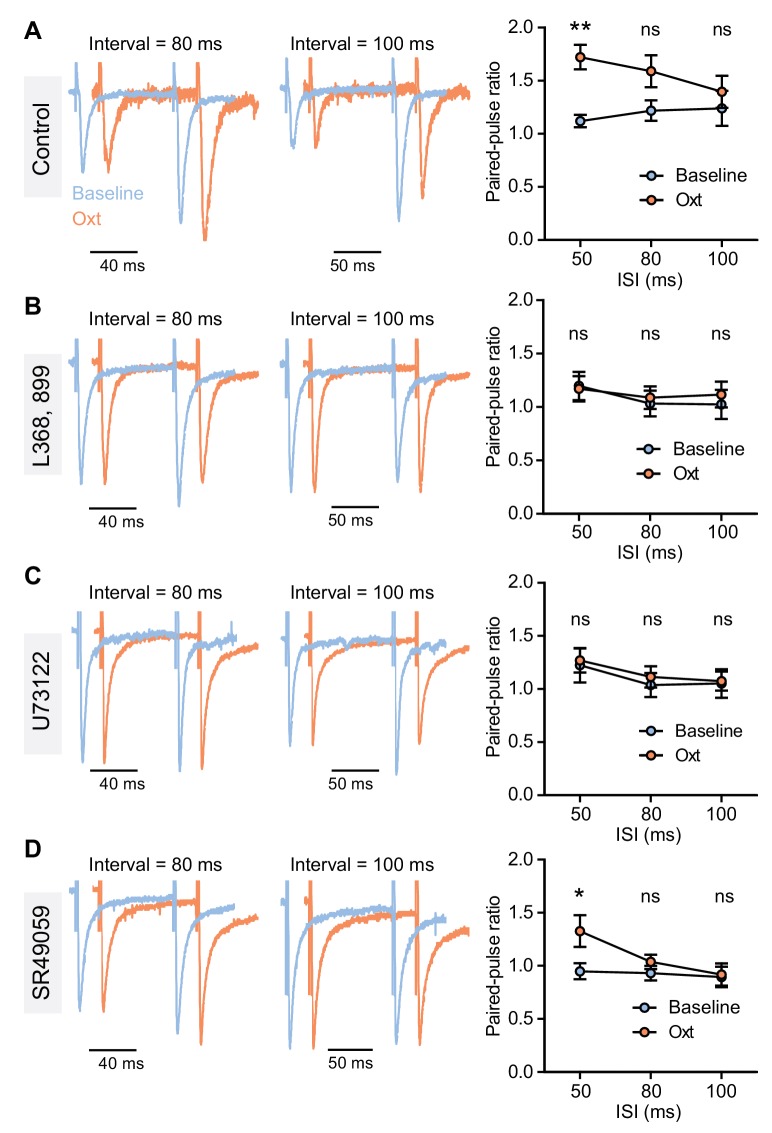
Oxytocinergic modulation of paired-pulse ratio in VTA DA neurons.(A) Left: traces from a VTA DA neuron showing pairs of EPSCs (80 and 100 ms ISI) in baseline condition and following oxytocin application. Traces are normalized to the amplitude of the first evoked response. Right: summary results show paired-pulse ratio during baseline and following oxytocin application across all 3 ISI intervals sampled. **p<0.01, *p<0.05, Friedman’s 2-Way ANOVA by ranks test, n = 8 neurons from six mice. (B) Same as (A), but in the presence of OxtR antagonist L368,899. n = 6 neurons from five mice. (C) Same as (A), but in the presence of PLC blocker U73122. n = 6 neurons from four mice. (D) Same as (A), but in the presence of V1aR antagonist SR49059. n = 8 neurons from five mice. *p<0.05, Friedman’s 2-Way ANOVA by ranks test. Error bars reflect SEM.